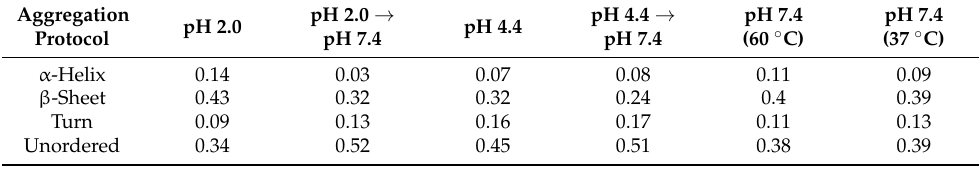
Table 3. Secondary structure estimation by Circular Dichroism using the web server BeStSel. Aggregation Protocol